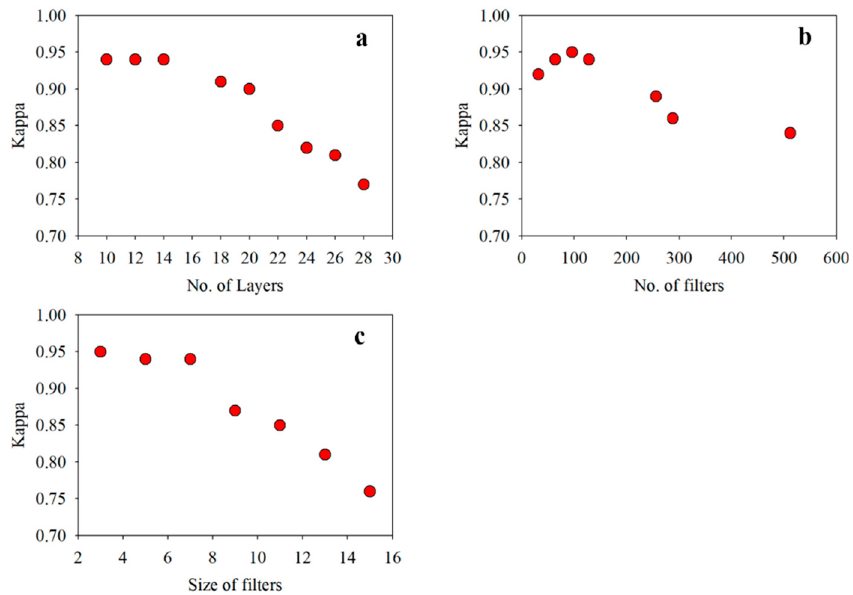
Figure 5. Sensitivity analysis of the variational capsule network (VCapsNet) in terms of ( a ) network depth; ( b ) size of filters; and ( c ) number of filters for classification.